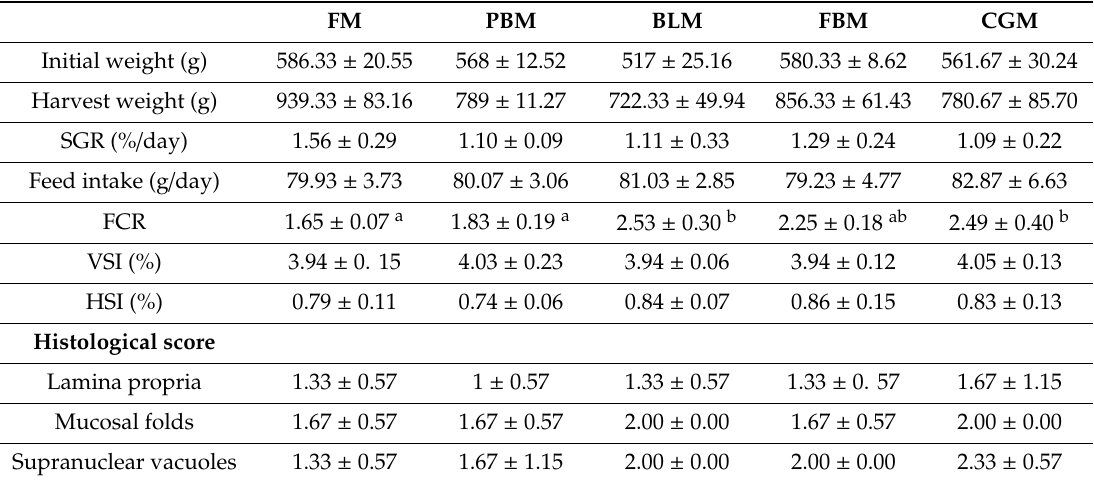
Table 1. Growth performance and histology